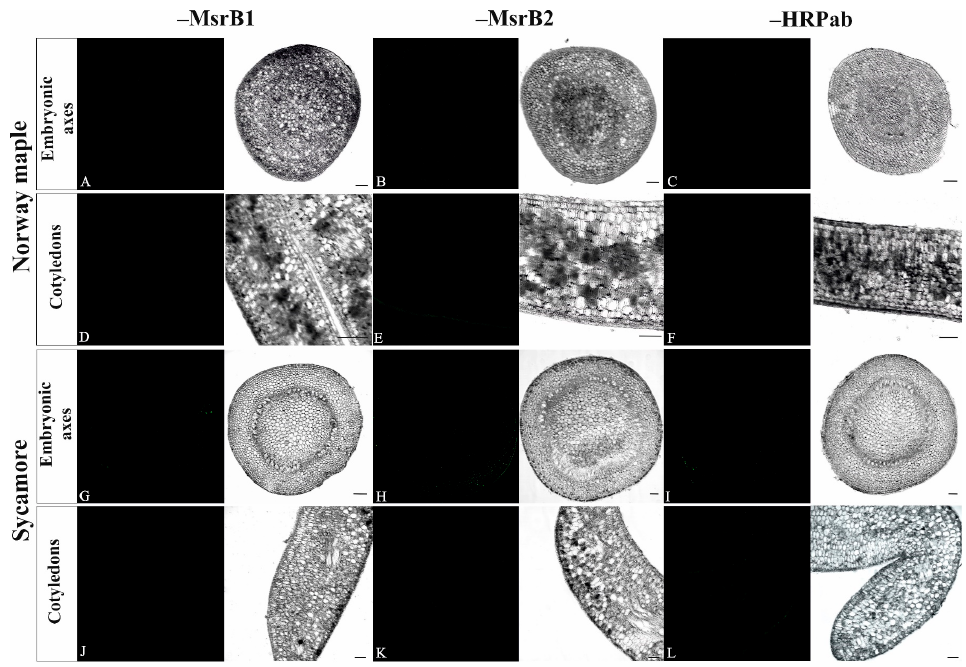
Figure 5. Negative controls for immunohistochemical reactions of MsrB1 and MsrB2 localization, performed on embryonic axes and cotyledons of Norway maple and sycamore seeds. The reactions were performed omitting: the primary antibody MsrB1 ( A , D , G , J ), the primary antibody MsrB2 ( B , E , H , K ), and the secondary antibody HRPab conjugated with horseradish peroxidase ( C , F , I , L ). For each reaction image an corresponding image in bright light is given.